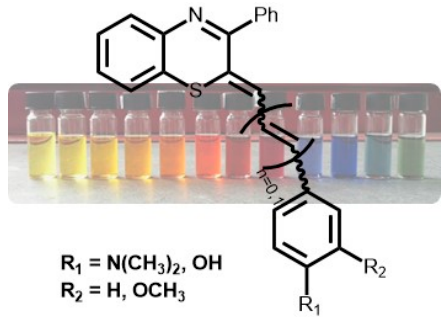
Figure 2. Structure of the trichocyanines synthesized and color variation associated to pH changes in the range 1–12 [27].